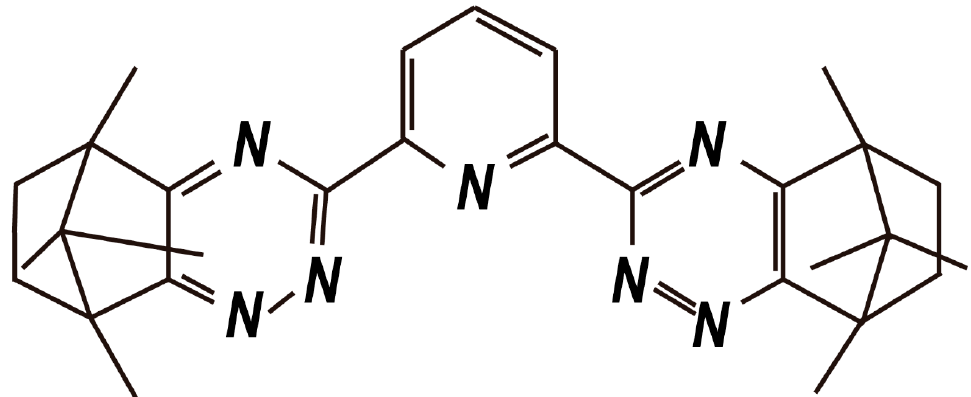
Figure 10. Structure formula of Me 2 -CA-BTP (5,6,7,8-tetrahydro-5,8,9,9-tetramethyl-5,8-methano-